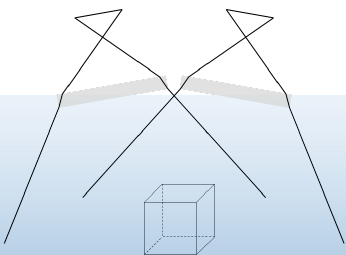
Figure 5. Convergent stereo camera setup with bundle-invariant interfaces.